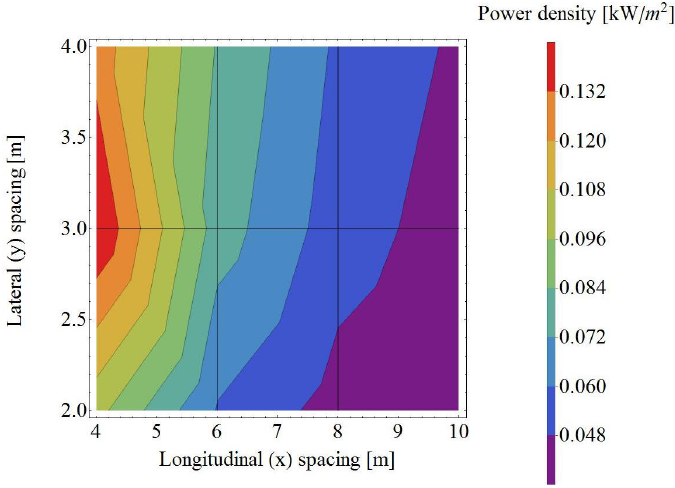
Figure 5. Graph of power density depending on turbine